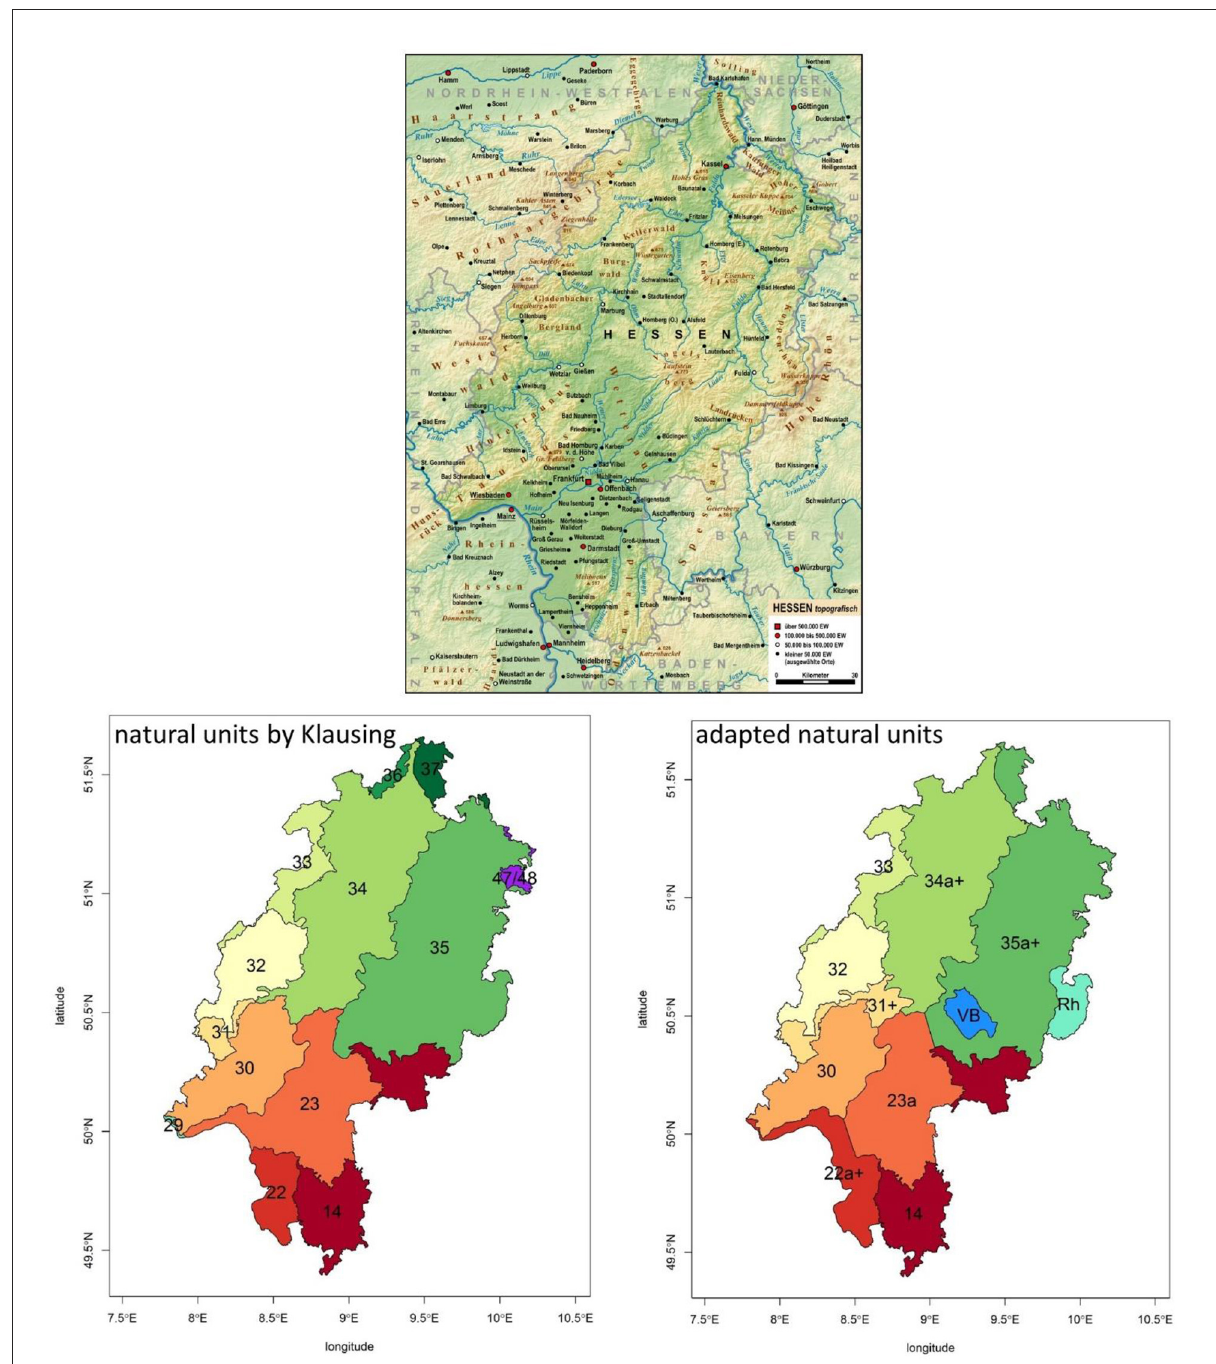
FIGURE1 Topographic map of Hesse (top, https://de.wikipedia.org/wiki/Hessen#/media/Datei:Hessen_topografisch_Relief_Karte.png) and map of “natural units” in the second refinement layer (Haupteinheiten) from the original Klausing-classification (bottom left) and resulting adapted natural units for spatial aggregation of climate model output (bottom right). Numbers correspond to: 14, Hessen-Franconian Mountains; 22, Upper-Rhine Lowland; 23, Rhine-Main Lowland; 29, Mittelrhein; 30, Taunus mountains; 31, Gießen-Koblenz-Lahn valley; 32, Westerwald mountains; 33, Bergisch-Sauerland mountains; 34, West Hesse mountain and valley Area; 35, East Hesse mountain area; 36, Weser mountain area; 37, Weser-Leine mountain area; 47/48, Thuringia basin (Klausing, 1988). VB, Vogelsberg; Rh, Rhön; “a”, adjustment of units by changing the boundary of the original unit; “ + ”, merging of original